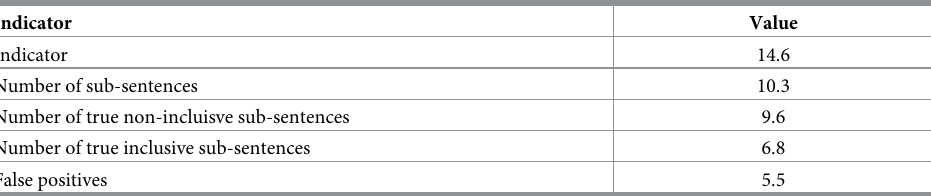
Table 7. Performance